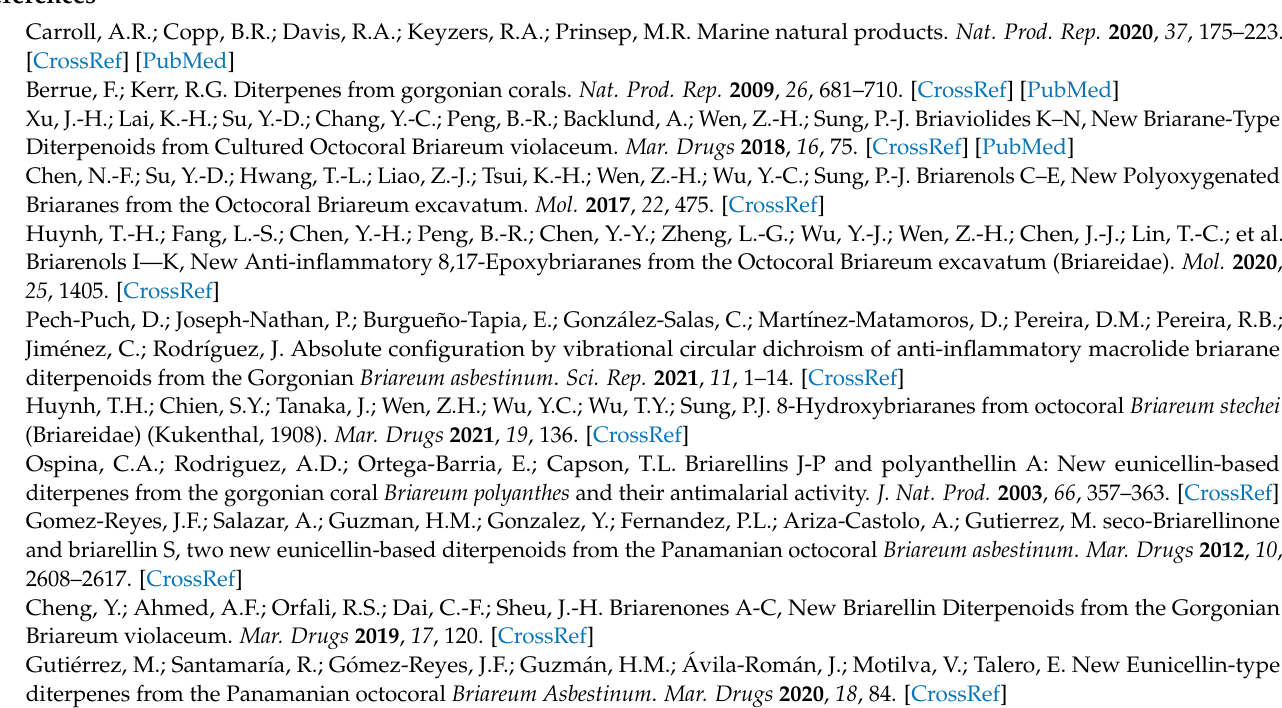
Supplementary Materials: Figure S1. HRESIMS spectrum of 1; Figures S2–S7: 1D and 2D